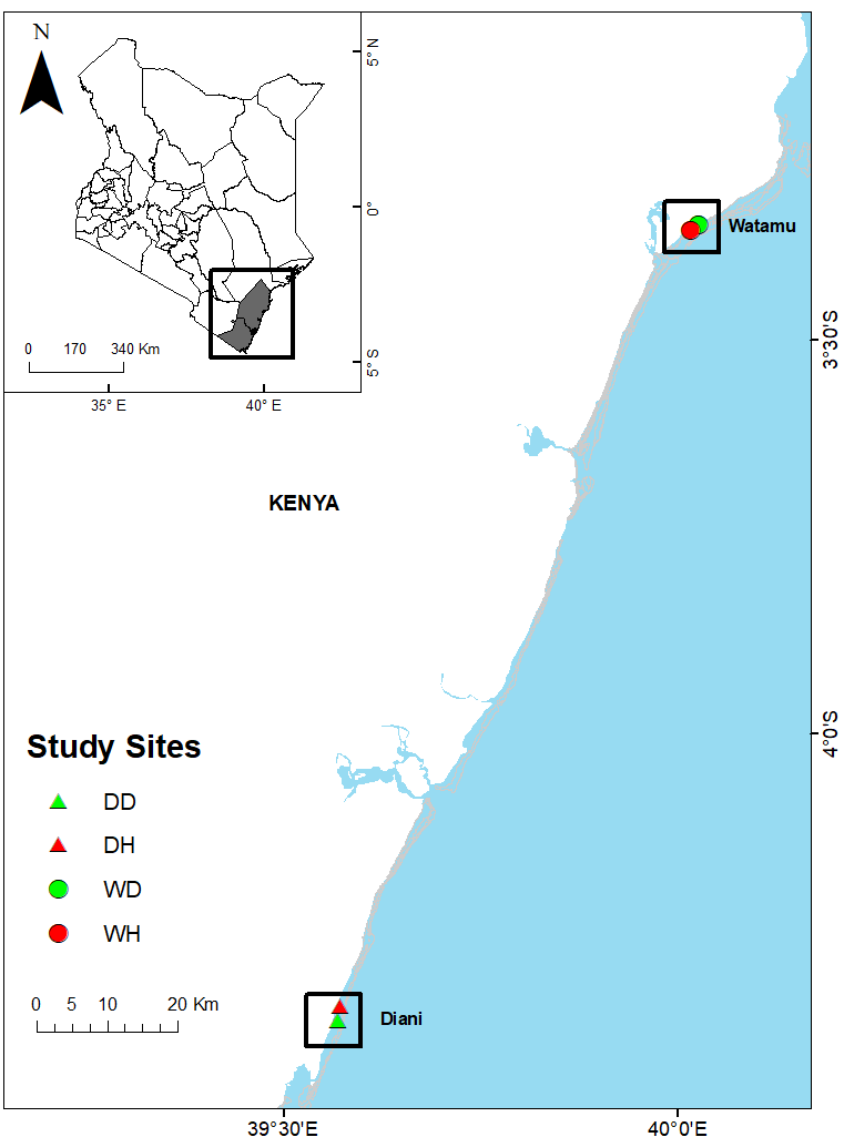
Figure 1. Map showing the location of the study sites and stations in Watamu and Diani in coastal Kenya.